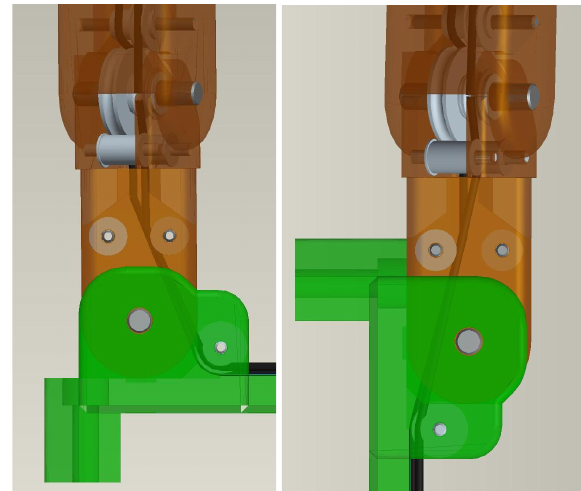
Figure 6. CAD model of the routing of the tendons of the thumb around the proximal joint: opposing configuration (left) and lateral configuration (right).